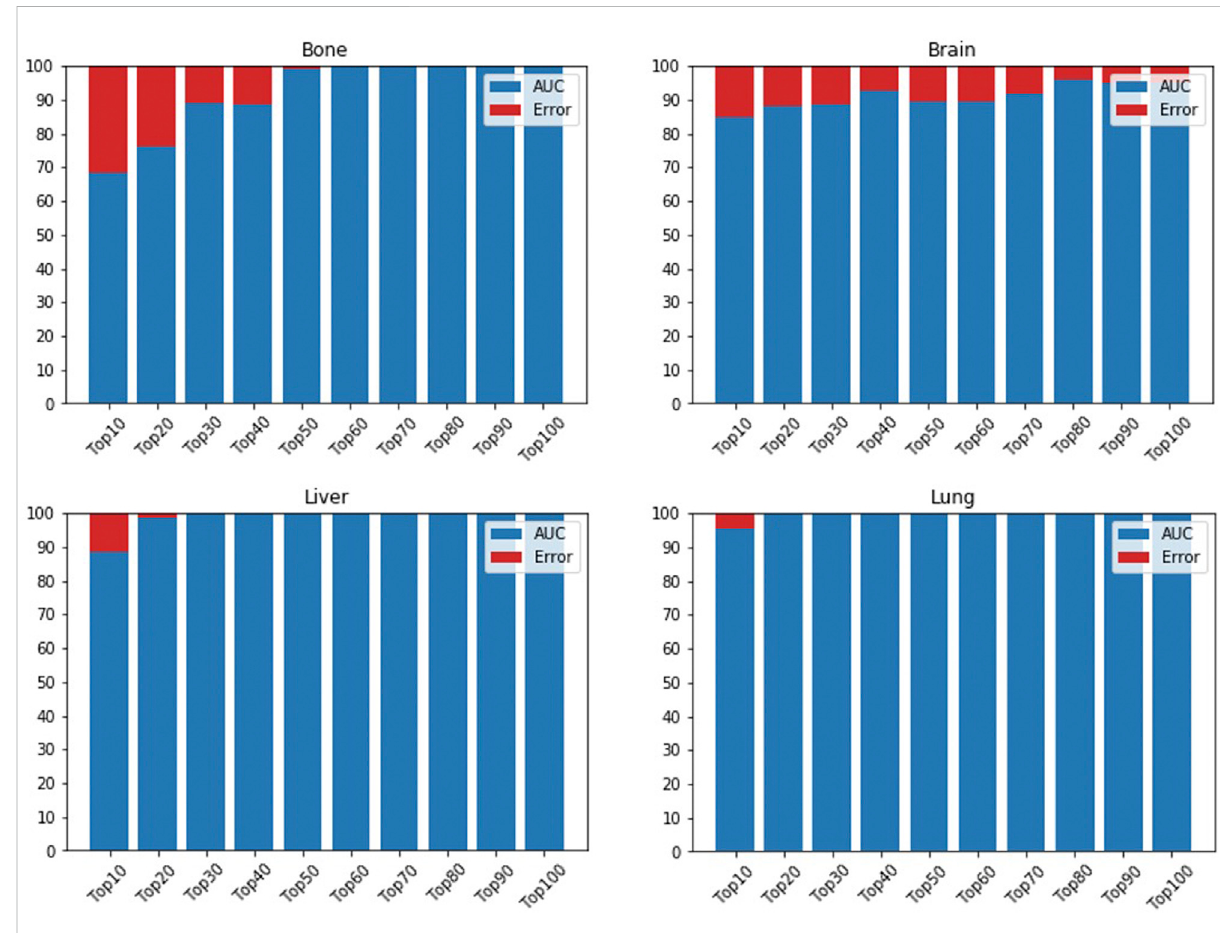
FIGURE 4 AUC is based on differentnumbers of featured genes using DNN for bone, brain, lung, and liver sites. AUC is indicated in blue, while error rate is shown in